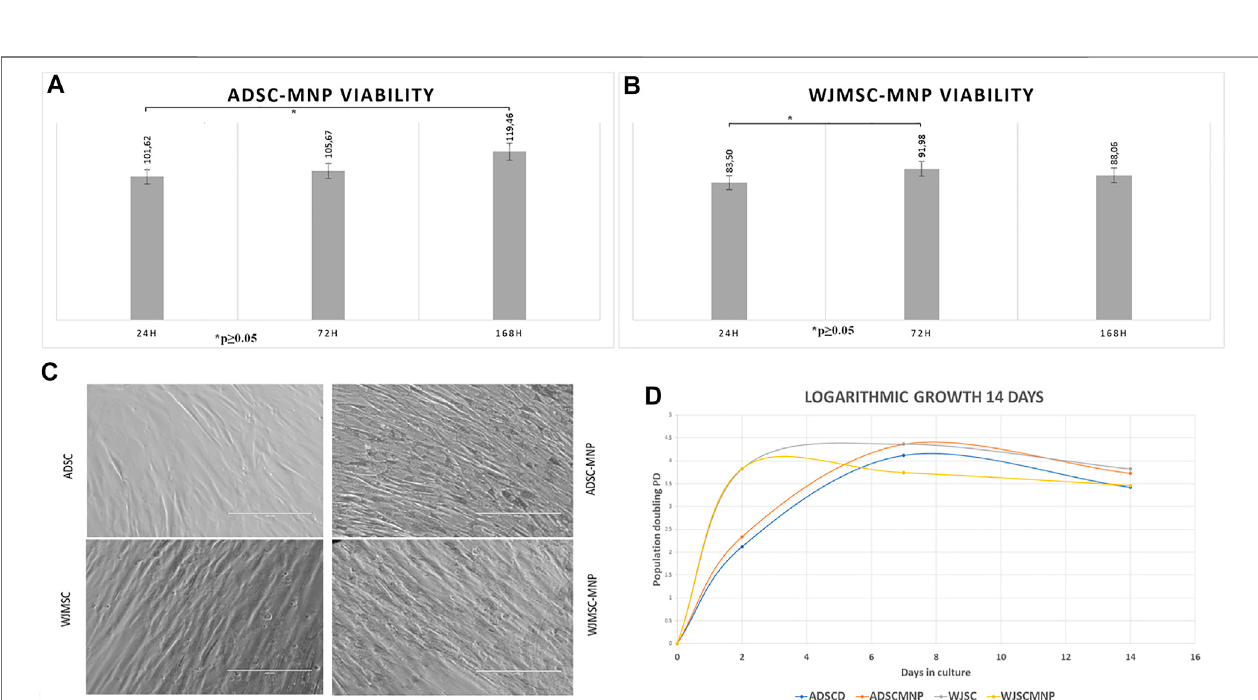
FIGURE 1 | Ultra-high resolution transmission electron microscopy (UHR-TEM) demonstrating the size of Fe 3 O 4 nanoparticles (A) ; magnetization loop of bare magnetite nanoparticles [ (B) -inset: details from the low- fi eld region]; magnetization loops of WJMSC and ADSC loaded with magnetite nanoparticles (C) .